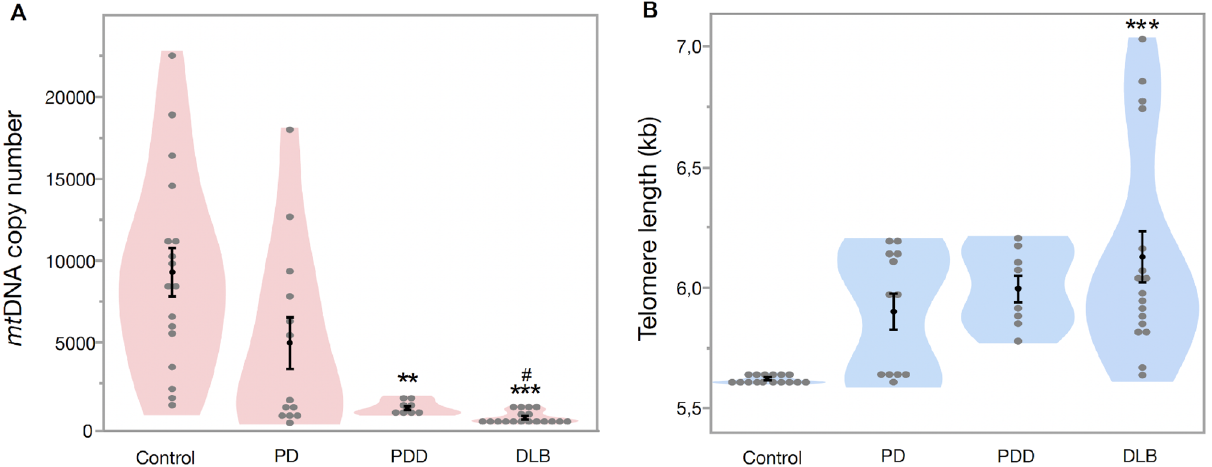
Figure 3. Mitochondrial DNA copy number and telomere length in prefrontal cortex tissue. ( A ) Mean MtDNA copy number in controls (9357.3 ± 1487.4), PD (5015.5 ± 1578.8), PDD (1036.4 ± 119.3) and DLB (410.7 ± 71.3). ( B ) Mean telomere length in control (5.60 ± 0.001 kb), PD (5.89 ± 0.07 kb), PDD (5.99 ± 0.01 kb) and DLB (6.12 ± 0.10 kb). Data are presented as mean ± SE. Controls vs patients, p < 0.05 = *, p < 0.005 = **, p < 0.0005 = *** and PD versus PDD/DLB, p < 0.05 = #, p < 0.005 =